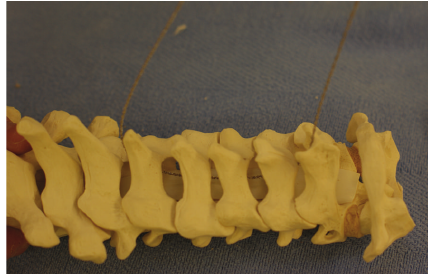
Figure 11: Instead of using a burr for the double-door laminoplasty technique, with the Tomita modification of the double-door lami- noplasty, the spinous processes are split in the midline with a Gigli- like